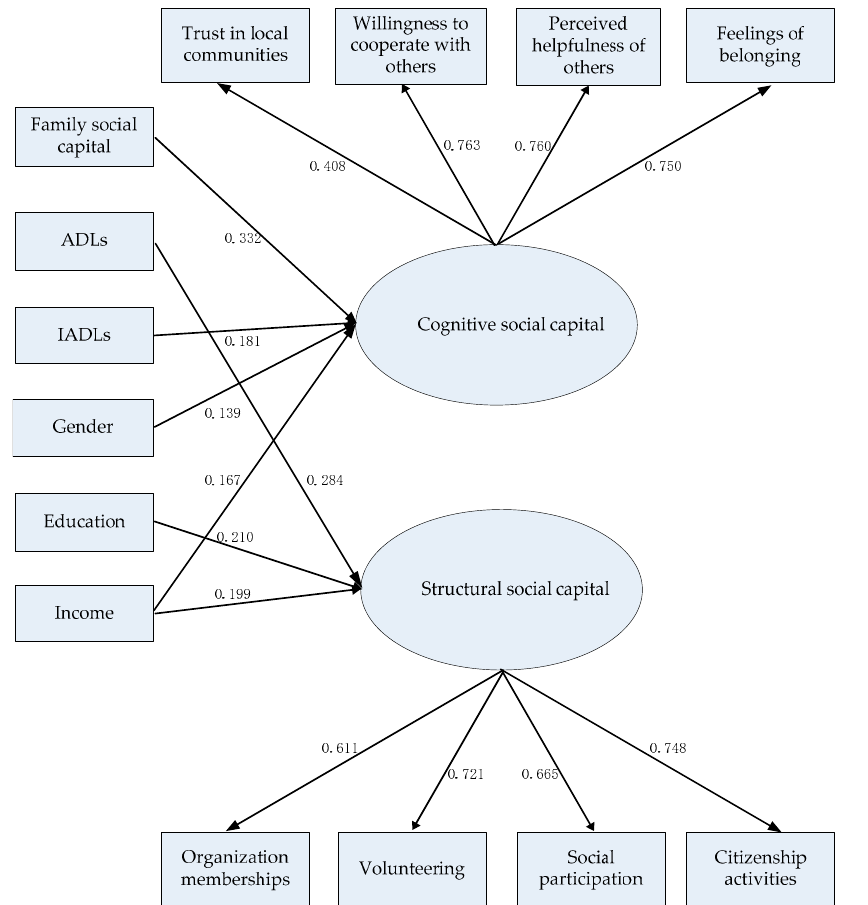
Figure 1. Final model of the determinants of cognitive and structural social capital. Standardized coefficients are reported. All of the estimates were statistically significant at the 0.05 level (two-tailed). Nonsignificant associations are not presented for the sake of simplicity. ADLs = activities of daily living. IADLs = instrumental activities of daily living.